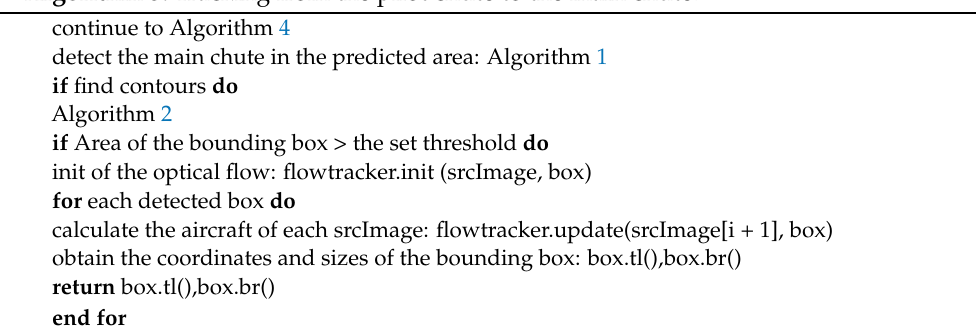
Algorithm 5: Tracking from the pilot chute to the main chute.